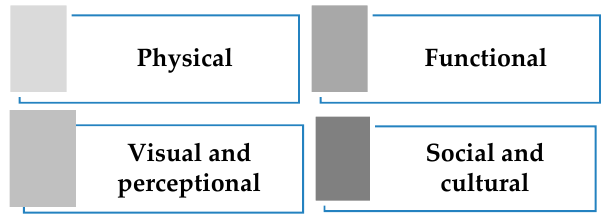
Figure 1. Urban morphology criteria.